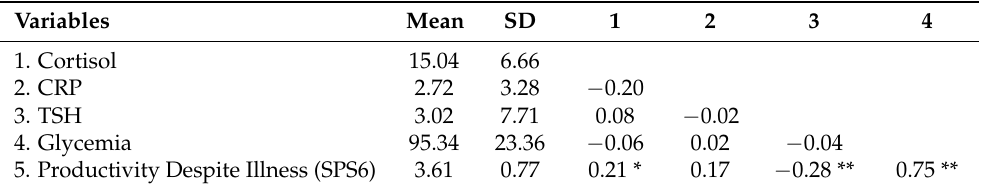
Table 2. Means, standard deviations, and Pearson correlations among